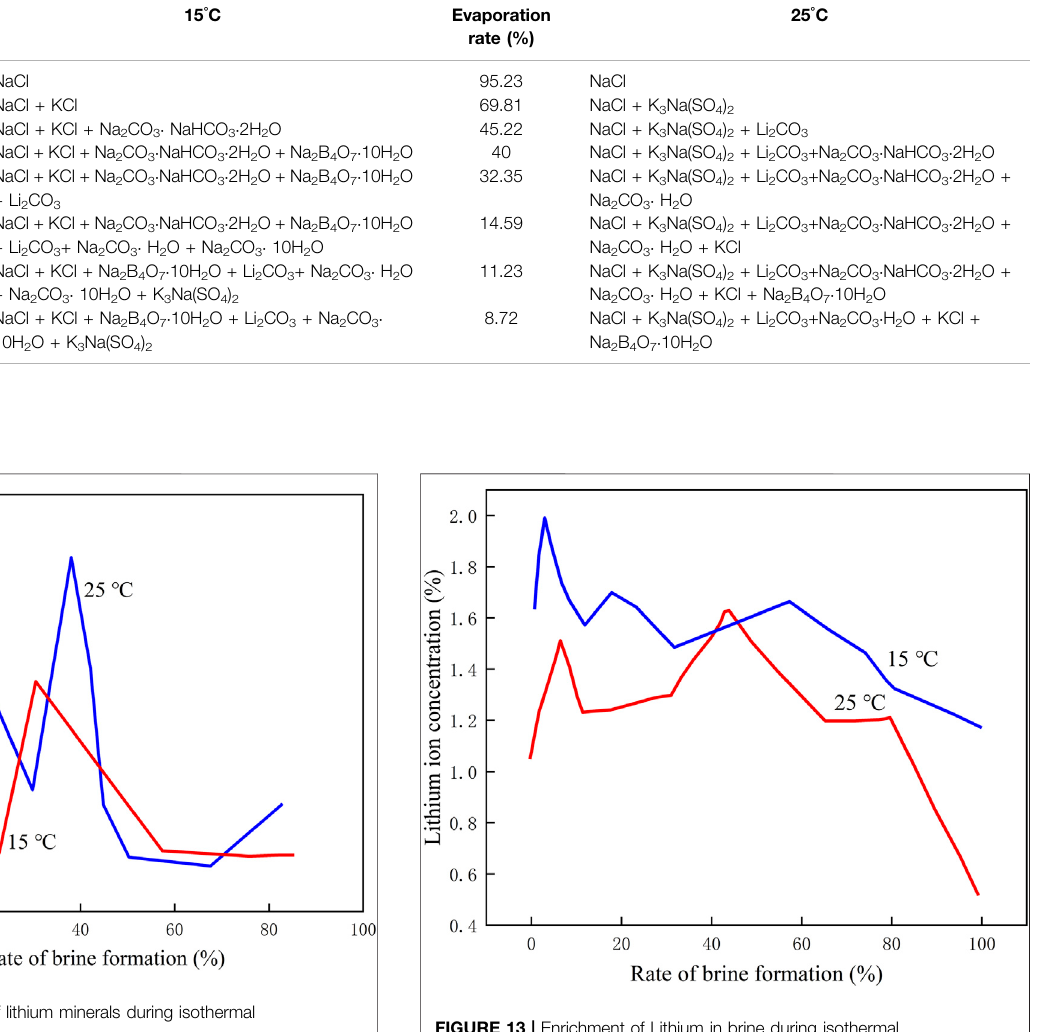
evaporation at 15 and 25 °